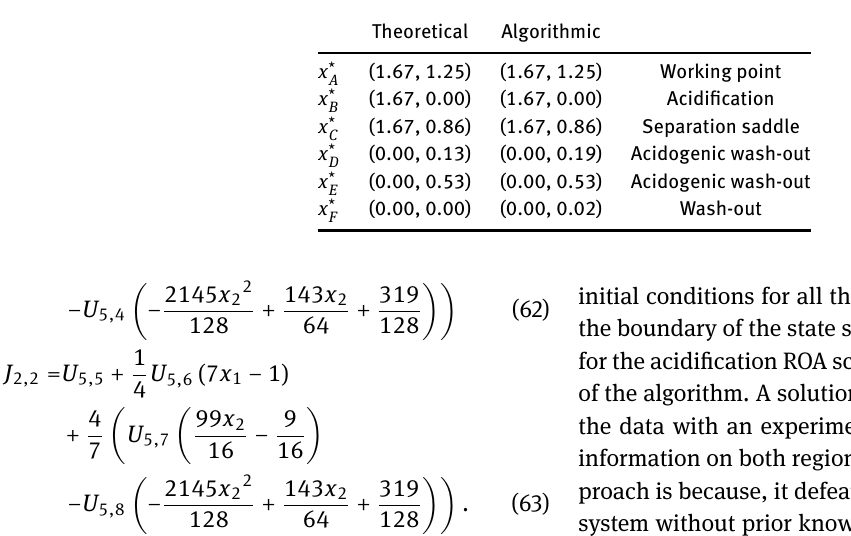
Table 5: Anaerobic digestion fixed points for u = 0.47 , x in